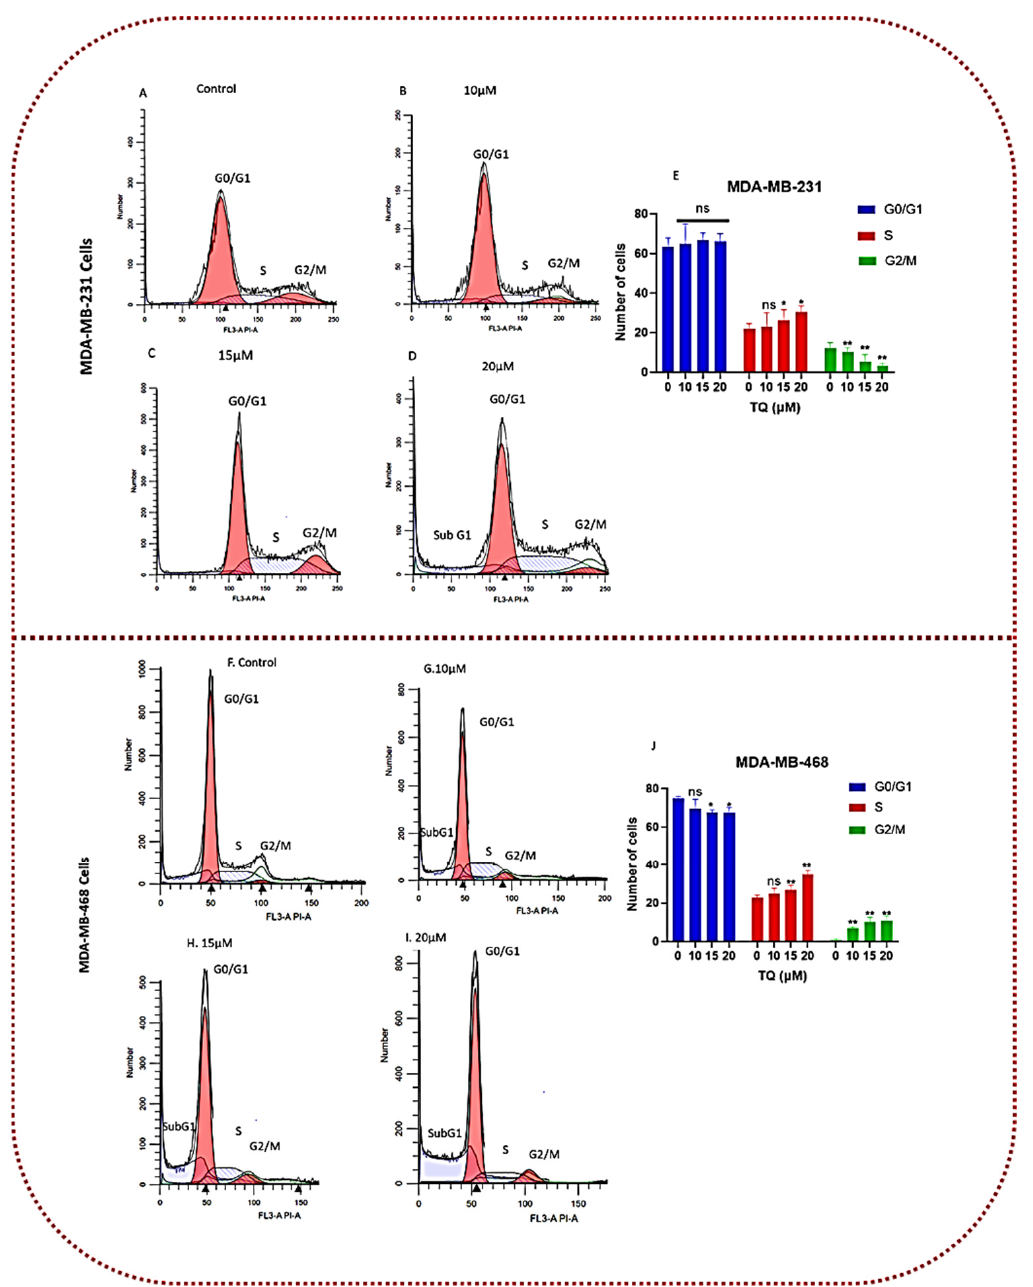
Figure 7. TQ affects cell cycle distribution in MDA-MB-231 and MDA-MB-468 TNBC cell lines. Both TNBC cell lines were treated for 24 h with TQ at three concentrations ranging from 0 to 20 µM. Sony